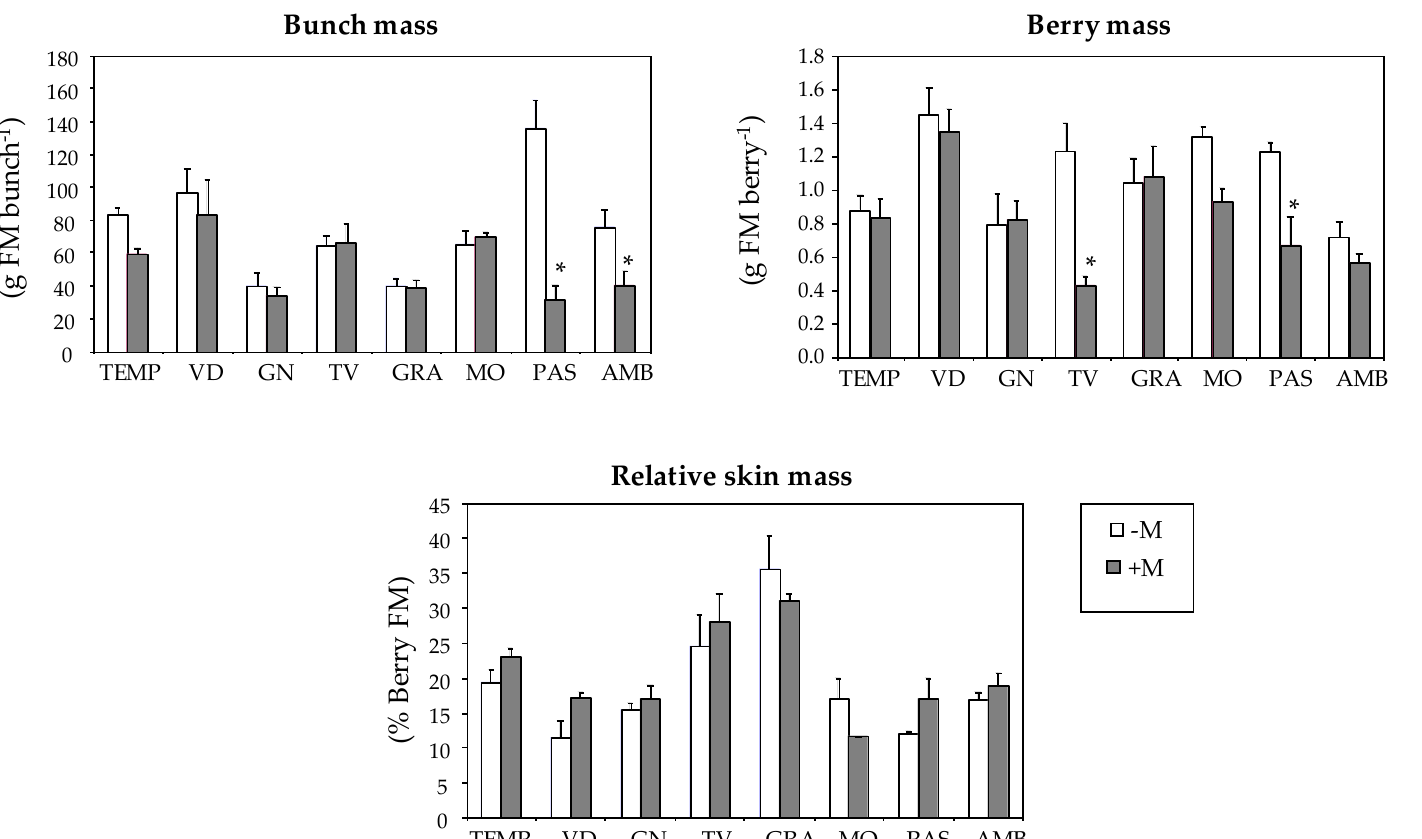
Figure 5. Bunch characteristics from fruit-bearing cuttings of ancient grapevine varieties inoculated with arbuscular mycorrhizal fungi (+M) or non-inoculated (-M). Values are means ± S.E. (n = 3-4). Within each variety, asterisks (*) indicate significant differences ( p ≤ 0.05) between +M and –M plants according to Duncan’s test. The variety labels can be found in Table 1.